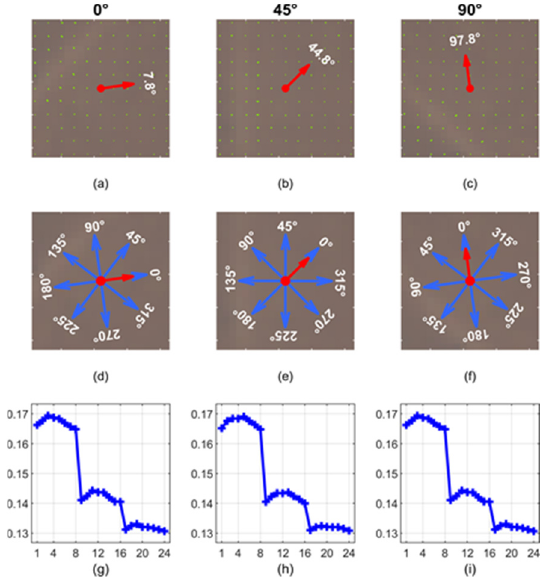
Figure 4. Computation steps for RISFL extraction for a pixel in a homogenous area with 0 ⁰ , 45 ⁰ , and 90 ⁰ rotation. (a–c) Local gradients (green arrows) and magnification of gradient at center pixel (red arrow), (d–f) azimuths in a rotated local system, and (g–i) RISFLs obtained for the center pixel of a 5 × 5 N with n = 8.